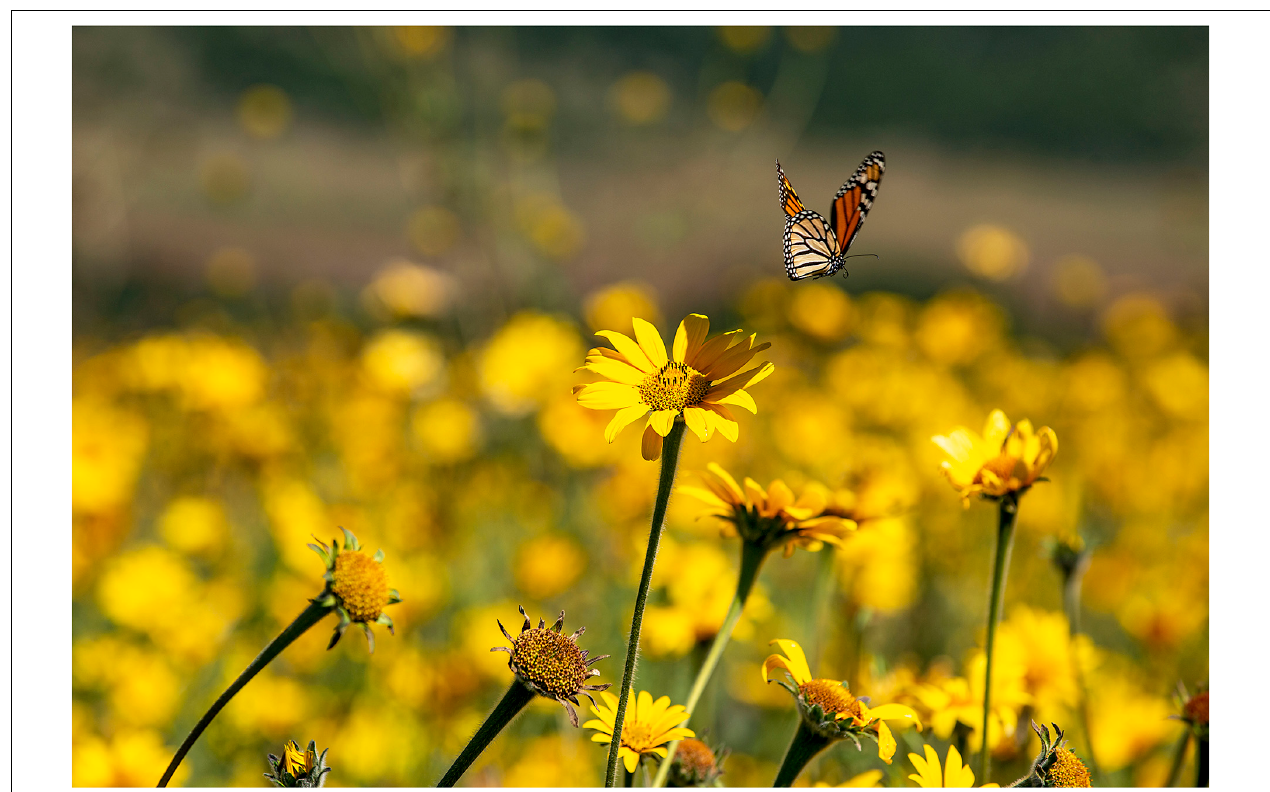
FIGURE 6 | A migrating monarch butterfly through Nuevo Leon, Mexico. Active nectaring on flowers by migrating monarchs throughout the region is commonly observed. Photo by Omar